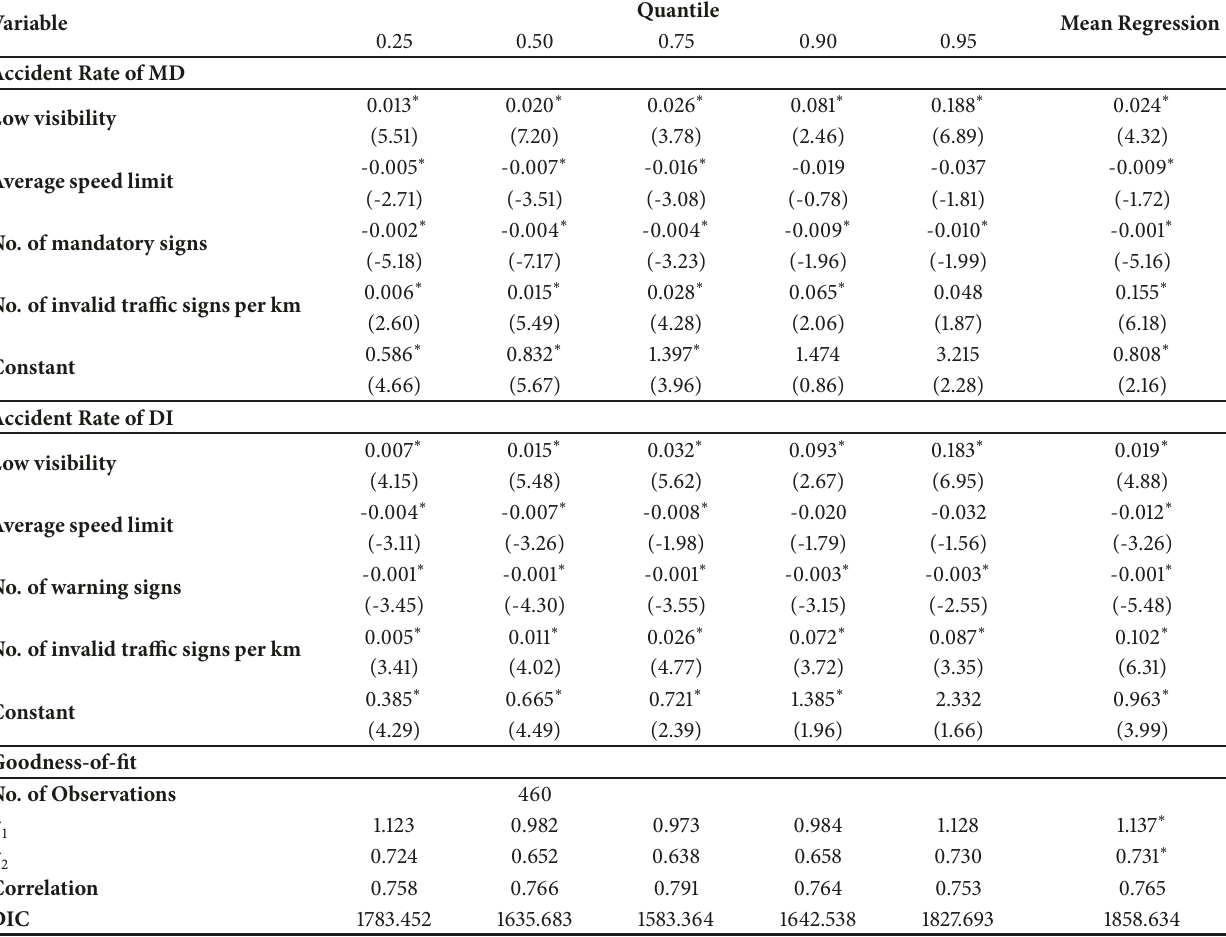
Table 2: Estimation results for Bayesian bivariate Tobit quantile/mean regression